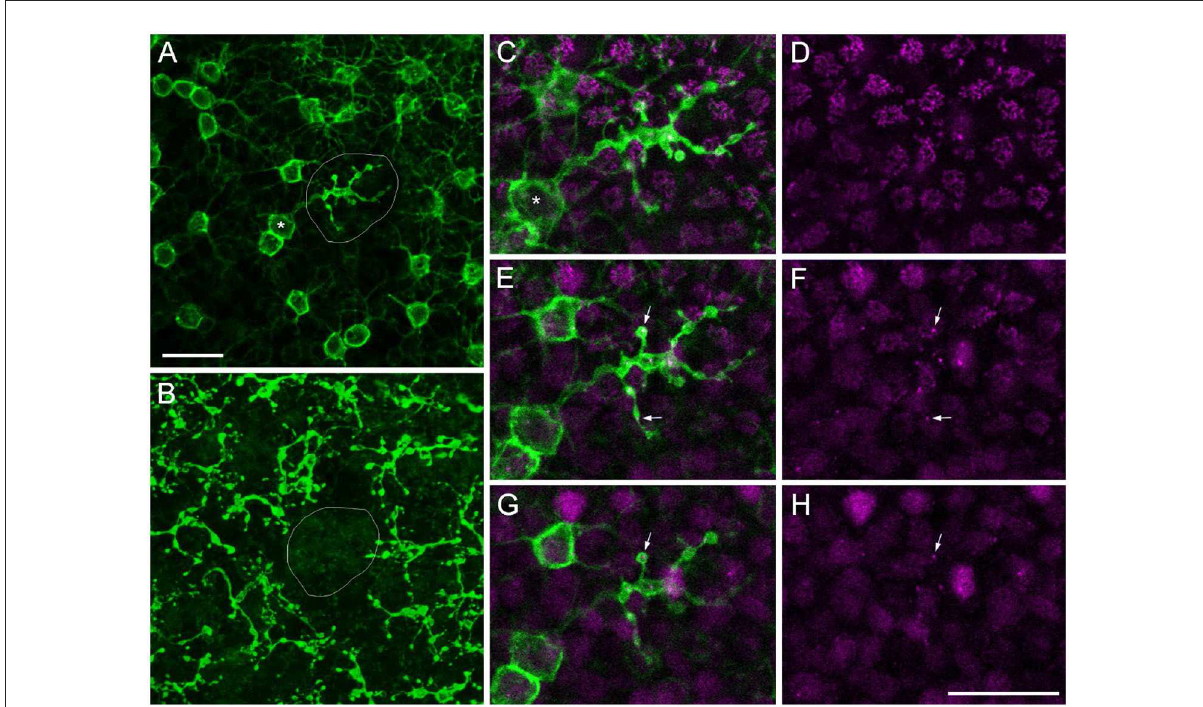
FIGURE5 Misplaced rod bipolar axon terminal projecting into the OPL . Confocal image stack of a marmoset retina immunolabeled with antibodies against PKC α (green) and Ctbp2 (magenta). (A) Confocal plane at the border of the outer INL to OPL with a misplaced RBC axon terminal (AT) in the middle of the image (circled) surrounded by several other RBC somata and their dendrites projecting into the OPL (upper right). The soma corresponding to the misplaced AT is highlighted (asterisk). (B) Same RBCs as in (A) with the focus onto their ATs deep in the IPL. The “original” position of the misplaced AT is empty. The misplaced AT is shown in higher magnification in three subsequent confocal planes in (C,D) (first plane), (E,F) (second plane), and (G,H) (third plane). (C,E,G) show the PKC α and the Ctpb2 labeling; (D,F,H) show Ctbp2 labeling alone. The small arrows point to Ctbp2 puncta within the misplaced AT. Scale bars in (A) for (A,B) and in (H) for (C–H) = 20 µ m